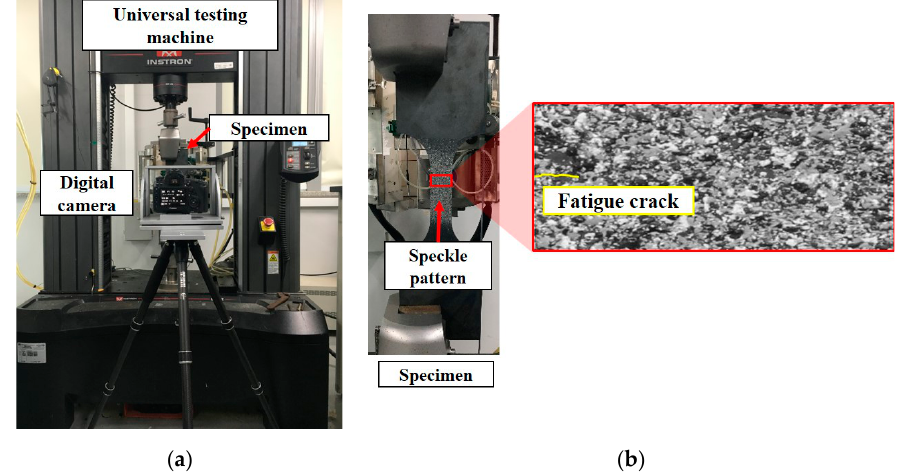
Figure 8. Experimental setup: ( a ) data acquisition system and ( b ) the ROI on the fatigue crack